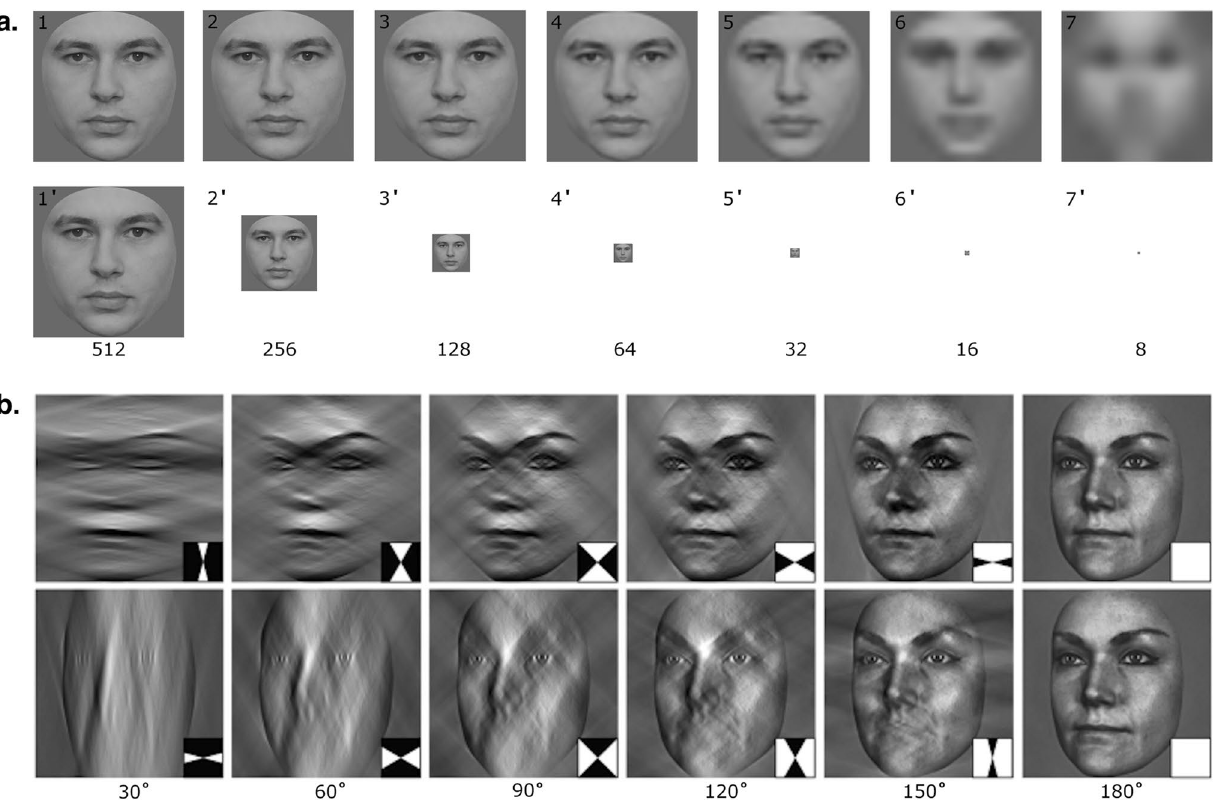
Figure 1. Examples of stimuli used in Experiments 1 and 2. ( a ) In Experiment 1 image size varied logarithmically from 512 pixels in width/height (images 1 and 1 ′ ) to 8 pixels (images 7 and 7 ′ ). The top row of a. shows the effect of the laplacian pyramid on SF con tent, and the bottom row displays the actual stimulus size. ( b ) In Experiment 2, images were bandpass filtered to preserve horizontal (top row of ( b )) or vertical (bottom row of ( b )) information in 15° steps from 0° to 180° (with every second step shown here). ( b ) was reproduced from Pachai et al. 31